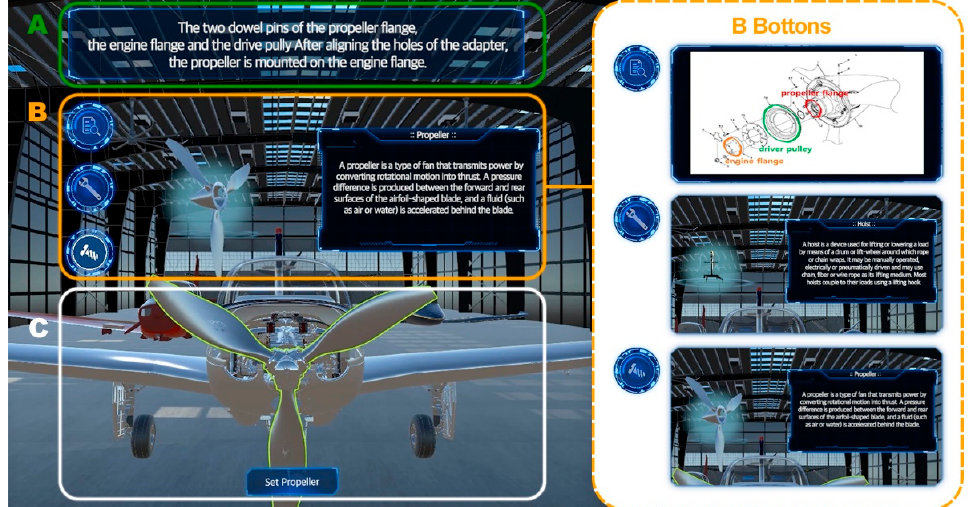
Figure 6. Aircraft maintenance simulation.